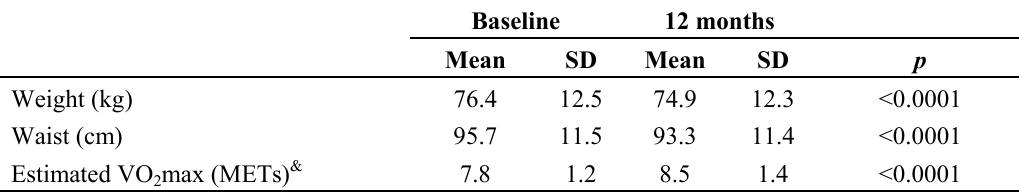
Table 2. Evolution of Weight, Waist, Estimated VO Value in 154 Women included in the 12-month Lifestyle Intervention